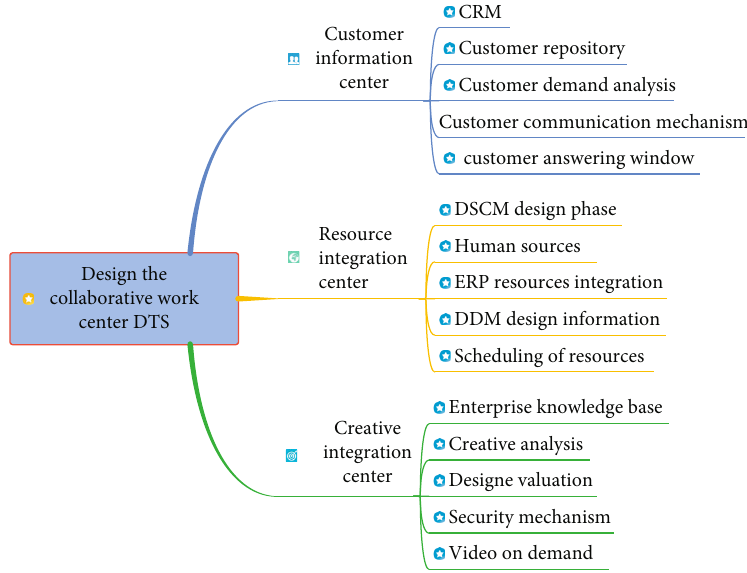
Figure 11: Overall frame diagram of the auxiliary design platform.